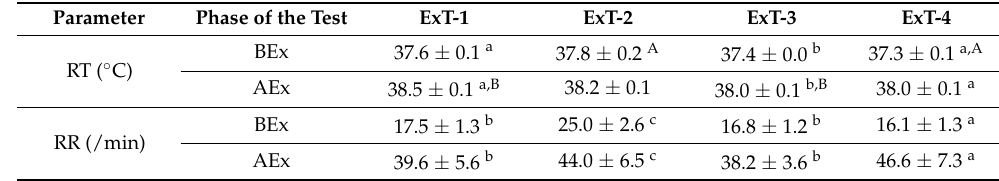
Table 4. Rectal temperature (RT) and respiratory rate (RR) in Lipizzan fillies before and after exercise (BEx and AEx) in tests 1 to 4 (ExT-1 to ExT-4).